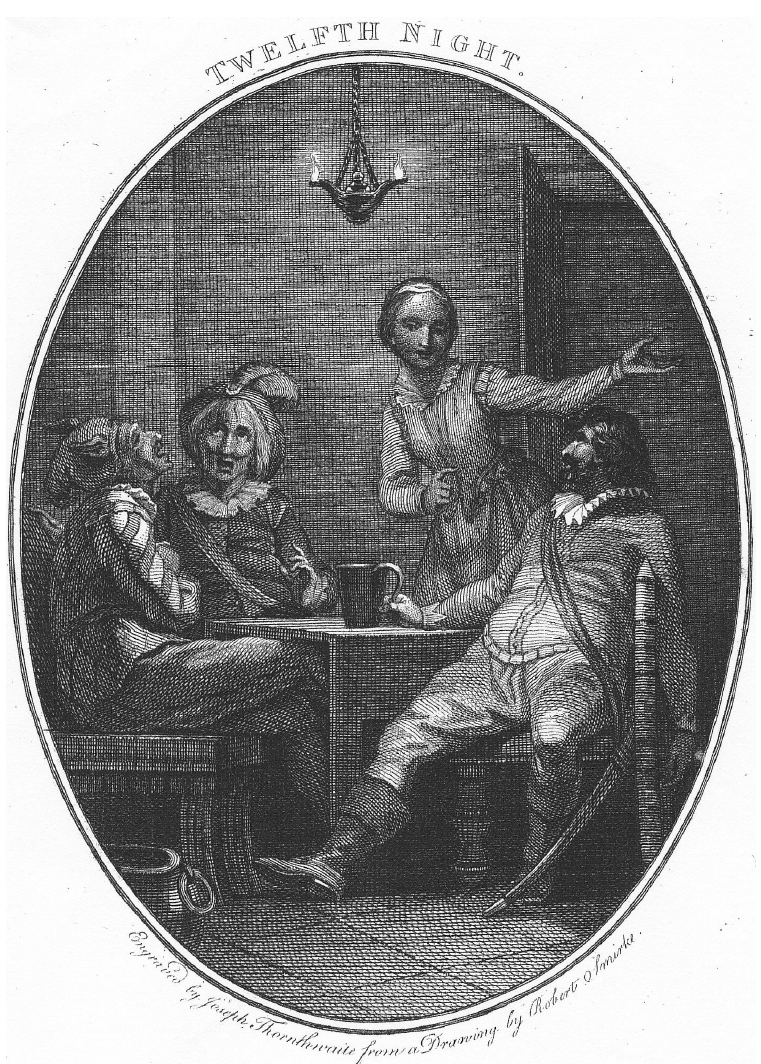
Figure 3. The picturesque beauties of Shakspeare [sic], being a selection of scenes, from the works of Figure 3. Engraving contained in The picturesque beauties of Shakspeare [sic], being a selection of scenes, that great author, ed. Ch. Taylor, with drawings by R. Smirke and T. Stothard, 1783–1787. from the works of that great author , ed. Ch. Taylor, with drawings by R. Smirke and T. Stothard,